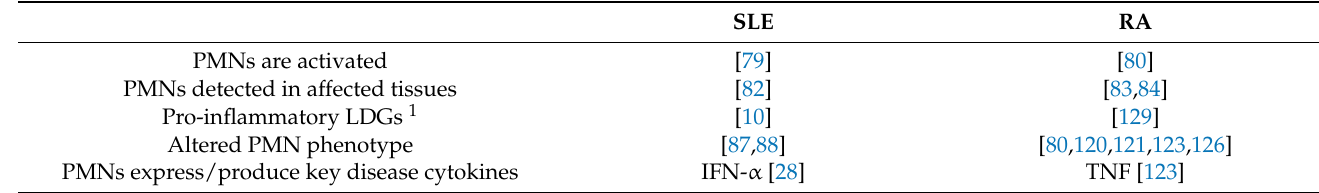
Table 1. Involvement of PMNs in SLE and